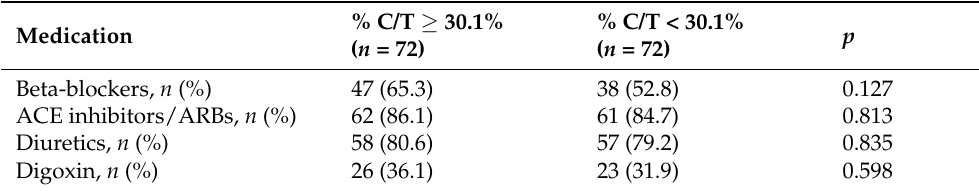
Table 2. Medication use.